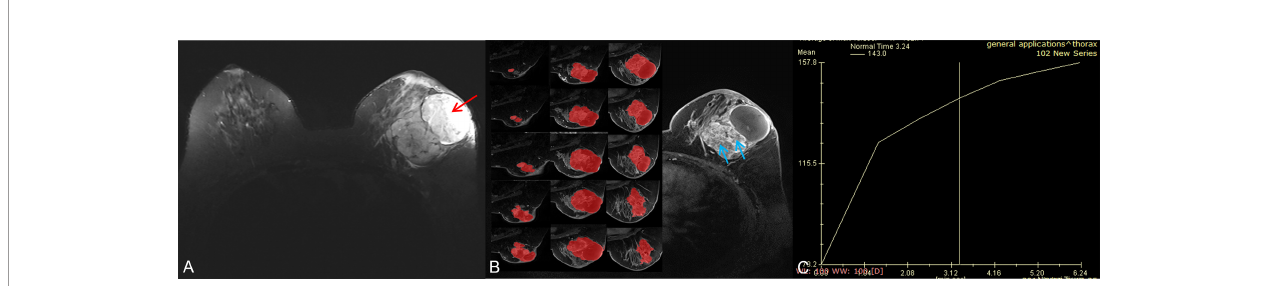
FIGURE 4 | A 56-year-old woman with a borderline/malignant phyllodes tumor. (A) Axial T2WI showed a heterogeneous mass with a huge cystic cavity (red arrow) in the left breast. (B) Axial DCE-MRI showed the mass with heterogeneous enhancement and large numbers of unenhanced areas with irregular walls (blue arrow); the segmentation of VOI was shown on the left series images. (C) The time-intensity curve was type I (persistent pattern).